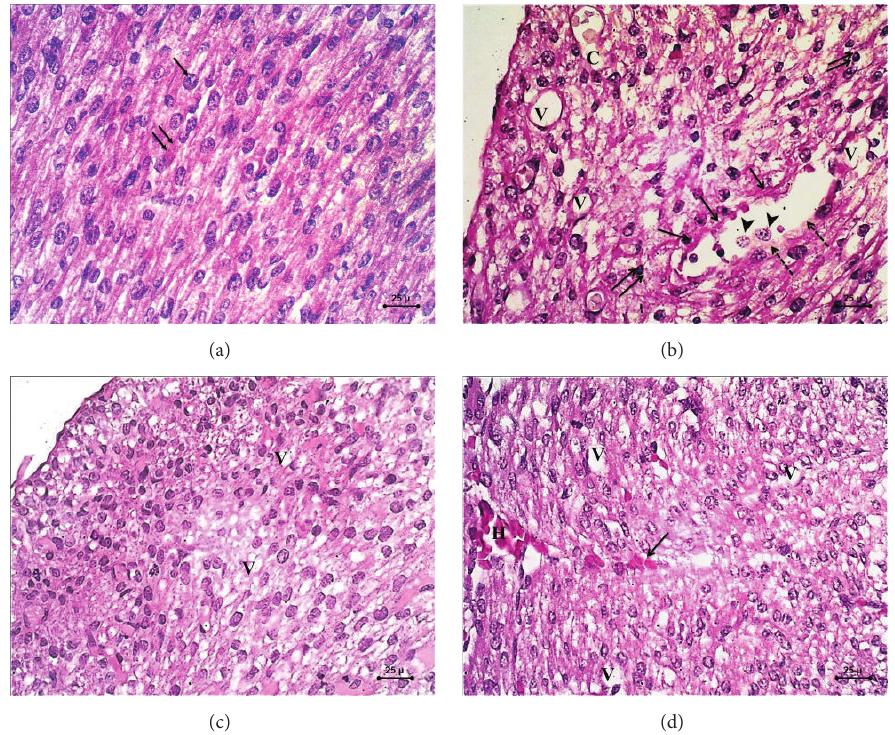
Figure 1: Photomicrograph of H&E ( × 400) sections in the fetal myocardium. (a) Control group showing normal striated pattern of the cardiomyocytes with centrally located nuclei (arrow) and eosinophilic cytoplasm (double arrow). (b) STZ-induced DM group showing myocardial disarray, marked vacuolar degeneration of the cardiomyocytes (V), fragmentation of the nuclei of cardiomyocytes (arrow) and pyknotic changes of the nuclei (arrow head), congested blood vessels (C), and discontinuation of the vessel wall (dashed arrow) with the presence of subendocardial thickening (double arrow). (c) STZ-induced DM treated with zinc group showing restored architecture of cardiomyocytes with the presence of mild vacuolar degeneration (V). (d) STZ-induced DM treated with insulin group showing focal improvement of the myocardium with the presence of vacuolar degeneration (V) and myocardial hemorrhage (H) with extravasated red blood cells within the myocardial tissue (arrow).